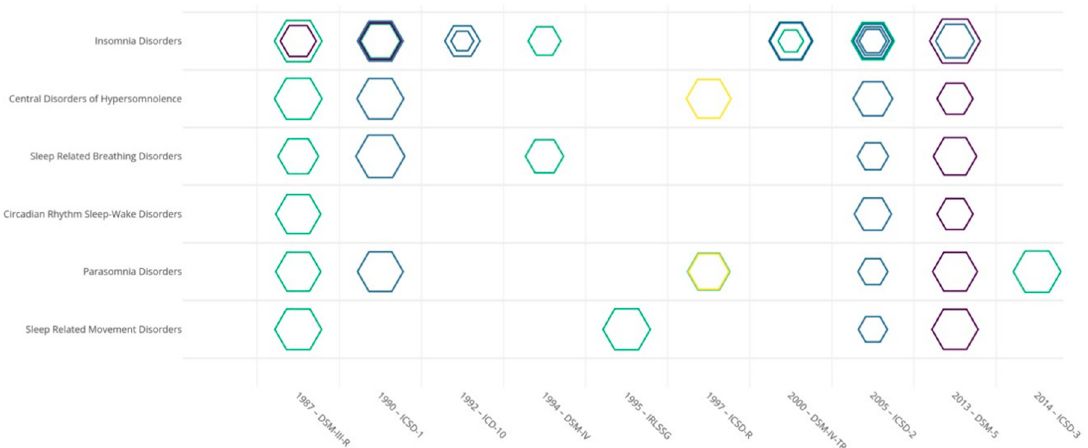
Figure 2. Graphical representation of 41 mean Cohen’s kappa coefficients retrieved (size of hexagons) organized in ordinate by the main sleep–wake disorder categories studied and in abscissa by the different classification diagnostic criteria studied, and ranging by year of publication. The size of the hexagons indicates the importance of the Cohen’s kappa coefficient: the larger the hexagon, the greater the Cohen’s kappa coefficient. Colors depend on the four reliability study methodologies identified. Method 1 (green) and Method 2 (blue) represent the “test–retest reliability” methods. Method 3 (yellow) and Method 4 (purple) represent the “joint interrater reliability” methods. The 69 Cohen’s kappa coefficients are not shown since the sleep–wake disorders were merged according to their current ICSD-3 main sleep–wake disorder category label. An interactive figure showing the references of the articles in which the Cohen’s kappa coefficient was retrieved is available at: https://chart-studio.plotly.com/~ChristopheGauld/48 (accessed on 21 December 2021).